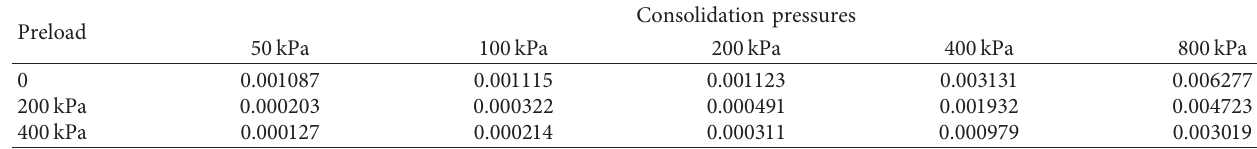
Table 11: Table of secondary consolidation coefficients of expansive soil under different preload conditions.